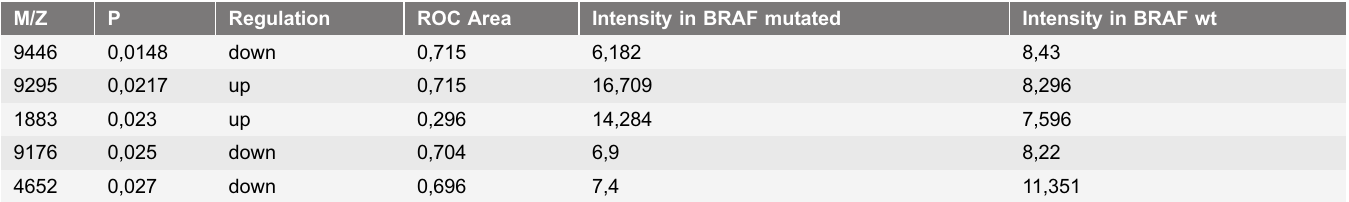
Table 2. The 4 discriminating m/z peaks among BRAF V600E/K mutated and BRAFwt MM patients. m/z: mass-to-charge ratio; P was generated by peak comparison between BRAF mutated and wild type patients.